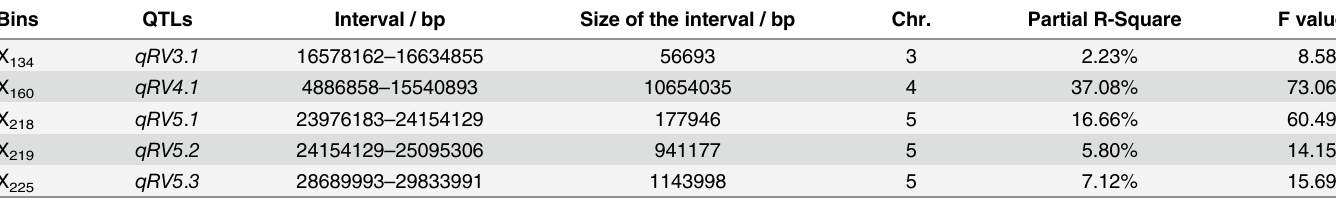
Table 10. QTLs mapping of